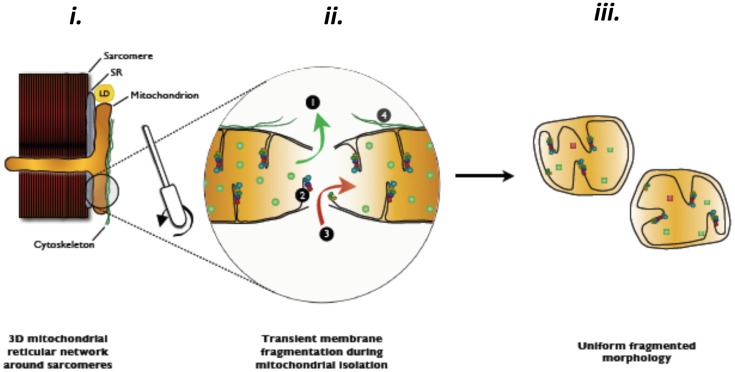
Hypothesized contamination and/or matrix dilution occurring with the transient rupture of mitochondrial membranes during mitochondrial isolation procedures. Reproduced with permission from Picard et al. (2011b).